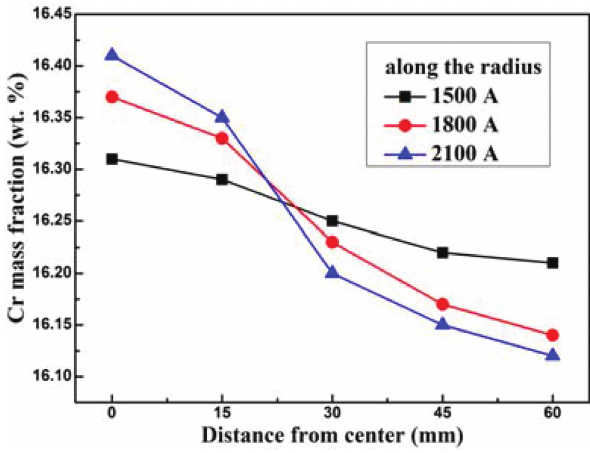
Figure 2: The distributions of Cr concentration along the transverse radius in ingots processed by electroslag remelting with different